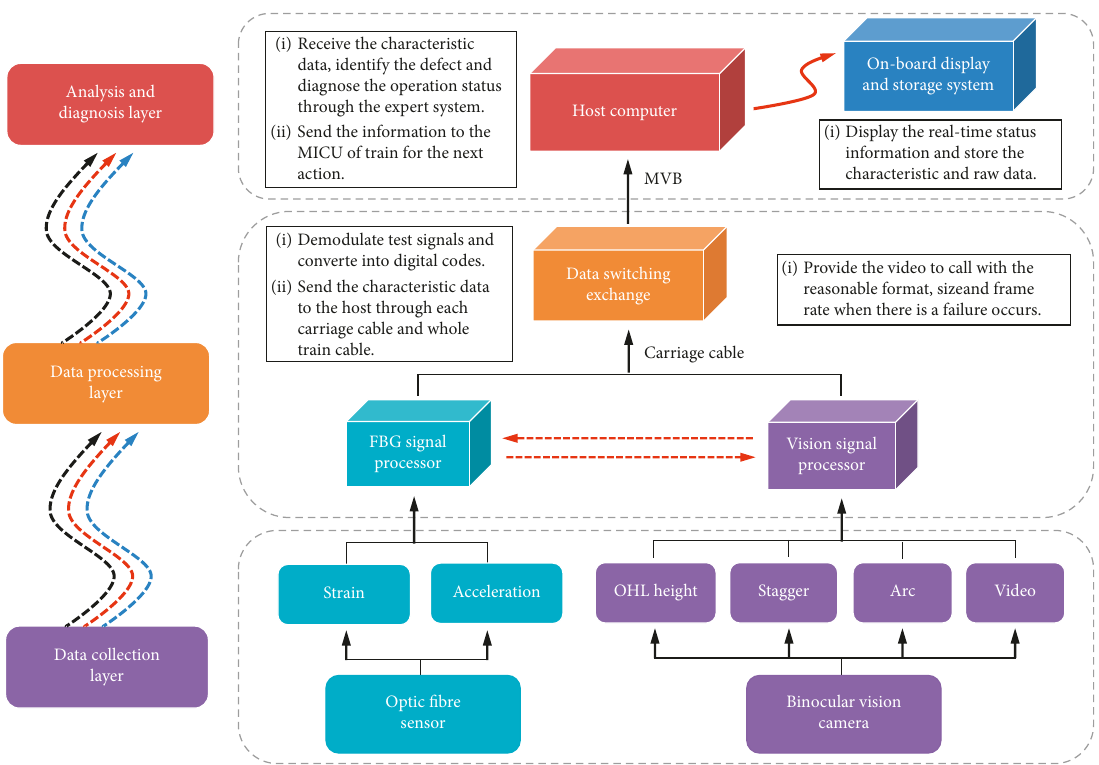
Figure 2: Data layer and structure diagrams of the on-board